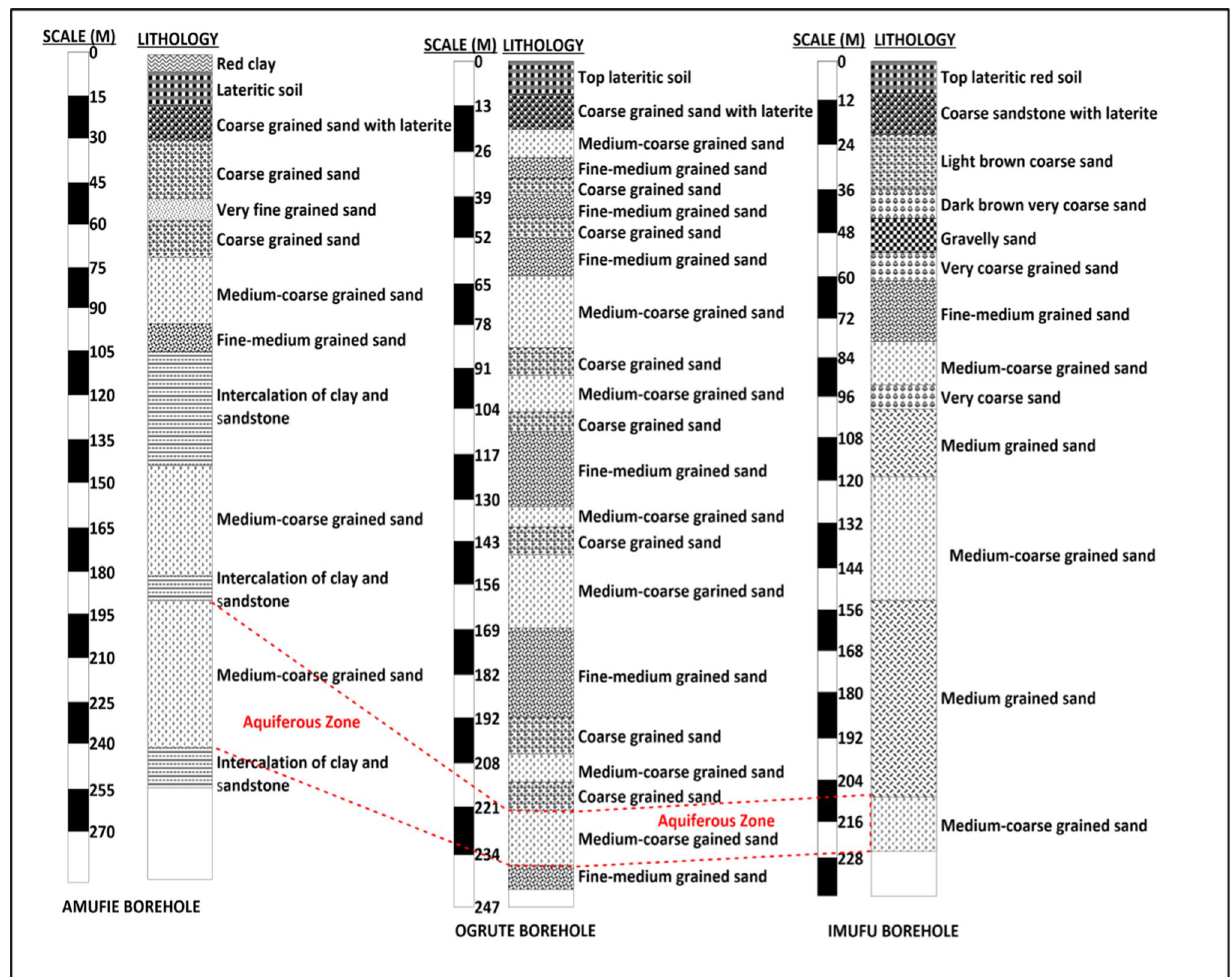
Fig. 4 Borehole lithology logs. a: borehole lithologic log close to VES 5, 22 and 29, b: borehole lithologic log close to VES 4, c: borehole litho- logic log close to VES